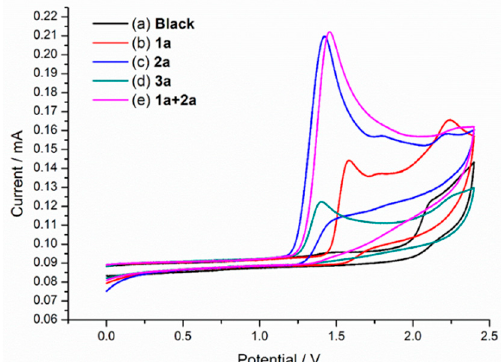
Figure 2. Cyclic voltammetry studies. Conditions: a 0.1 M n -Bu 4 NPF 6 solution in MeCN/HFIP = 4:1 at room temperature; a glassy carbon working electrode, Ag/AgCl (3 M KCl) reference electrode, and a graphite counter electrode, respectively. Scan rate: 100 mV/s. (a) Black line: background; (b) Red line: 1a (1 mM); (c) Blue line: 2a (1 mM); (d) Green line: 3a (1 mM); (e) Pink line: 1a (1 mM) + 2a (1 mM).